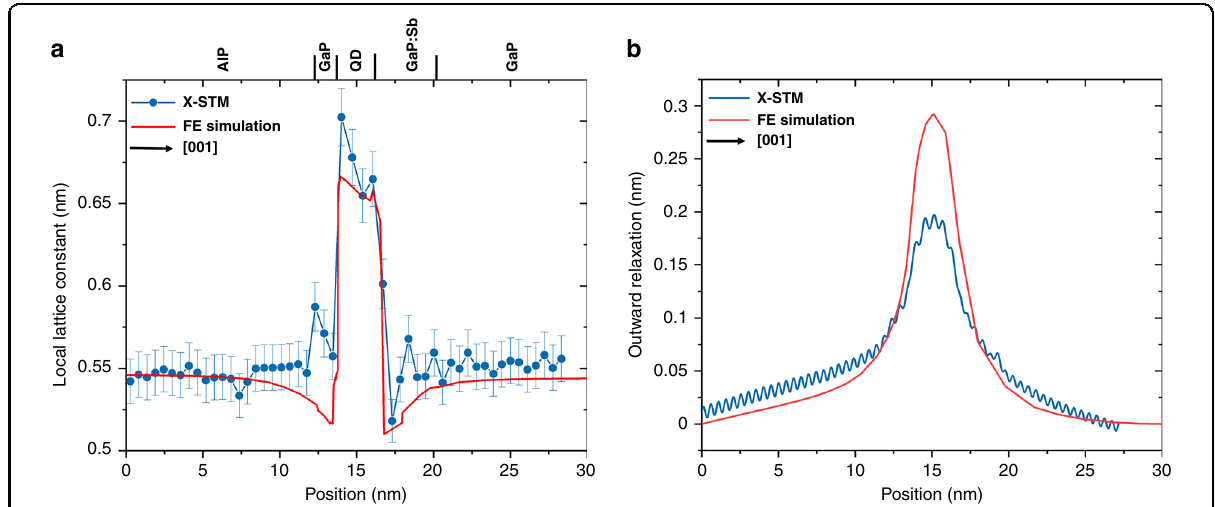
Fig. 7 FE simulations fi tting the experimental X-STM results. a Lattice constant pro fi le of the biggest QD in Fig. 1 (second QD from left) as a function of position in the growth direction (from left to right). The blue points represent the measured lattice constant with an FE simulation in red for a composition of In0.3Ga0.7As0.85Sb0.15. Different layers are marked on top of the pro fi le; b X-STM height pro fi le showing the outward relaxation of the same cleaved QD with an FE simulation in